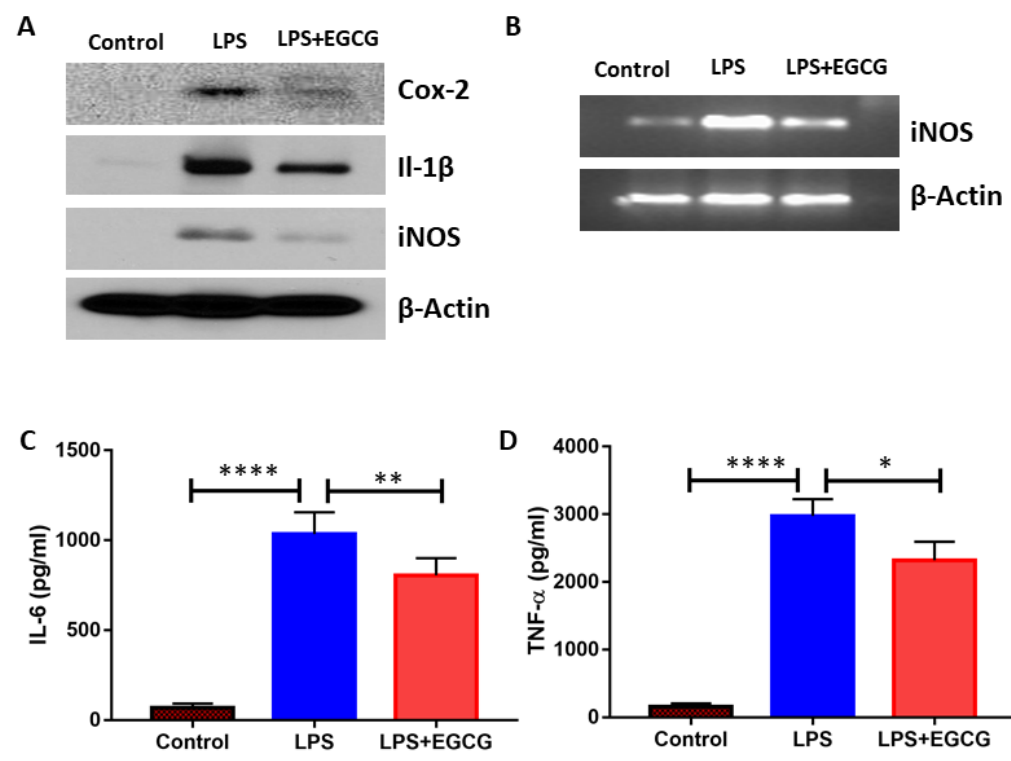
Figure 3. E ff ects of EGCG on LPS-induced M1 inflammatory mediators. ( A ) RAW cells were stimulated with LPS in the presence or absence of EGCG for 24 h and proinflammatory markers were analysed. Immunoblots of COX2, iNOS and iL-1 β demonstrated suppressed activity of these proteins by EGCG in macrophages. ( B ) iNOS mRNAs were measured using RT-PCR ( C ) The BAL TNF- α secretion increased in the LPS-instilled group and declined after EGCG treatment. ( D ) The LPS also increased IL-6 secretion and the EGCG treatment controlled the LPS-induced secretion. Significant di ff erence * p < 0.05, ** p < 0.01 and **** p < 0.0001 The data are expressed as mean ± SEM. ( n = 4 or more animals per group).